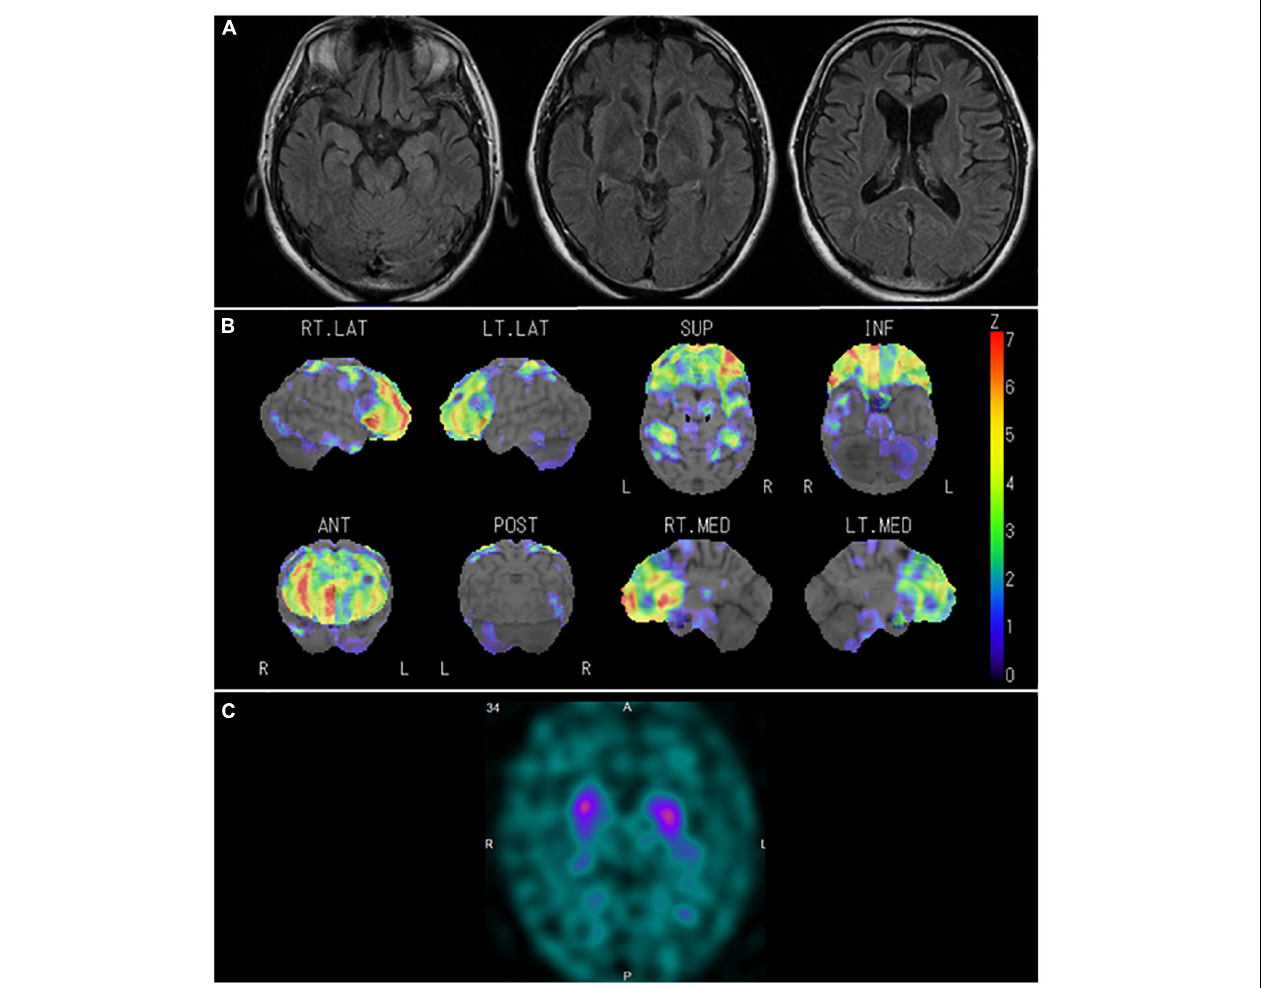
FIGURE 4 | Neuroradiological findings in Case 1. (A) Magnetic resonance imaging shows marked bilateral frontal lobe atrophy. (B) Brain perfusion single photon emission computed tomography (SPECT) three-dimensional stereotactic surface projection analysis (Nihon Medi-Physics, Tokyo, Japan) shows significant bilateral frontal lobe hypoperfusion. The color scale for the Z score is shown on the right side of the figure. Presented in color if the Z-score was > 0. (C) Dopamine transporter (DAT) SPECT shows remarkably reduced DAT availability in the bilateral